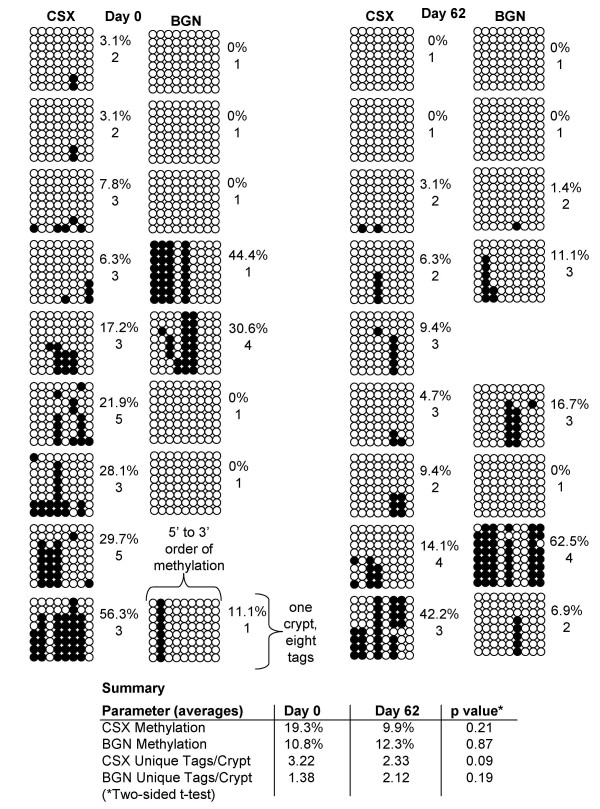
Crypt methylation before and neo-adjuvant therapy. There are eight tags per crypt with each tag arranged in a 5' to 3' horizontal order of CpG sites. CSX (eight CpG sites) and BGN (nine CpG sites) tags were sampled from eight of the same crypts. Crypt methylation patterns are summarized by percent methylation and numbers of unique tags per crypt. Methylation patterns were not significantly different before and after neo-adjuvant therapy, with averages summarize in the Table. The seemingly random methylation patterns are consistent with a model [4] in which stochastic methylation errors start to accumulate from birth.